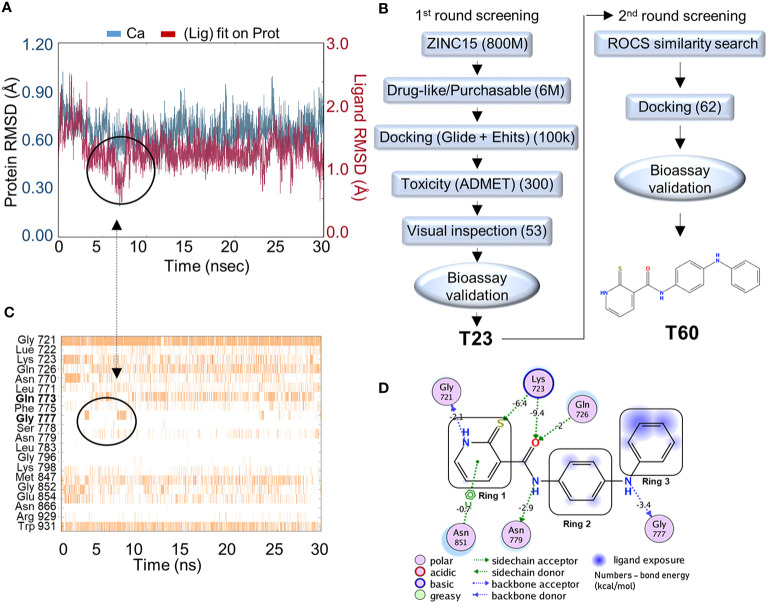

In silico screening for TOP2 inhibitors. (A) Molecular dynamics simulation of the docking pocket (blue) and T60 inside the TOP2A docking pocket (red) in 30ns. (B) A computer-aided drug design (CADD)_pipeline was applied to screen for TOP2 binders. Two rounds of virtual screening protocol combined with K-DNA decatenation and relaxation bioassays led to the discovery of the lead compound, T60. (C) A bar chart of protein–ligand contacts during the 30 ns simulation period. The interchanging bond formation (circled) between Gln773 and Gly777 is corresponding to T60 RMSD (circled) from (A) in the first 8 ns. (D) A schematic diagram shows T60 atoms interacting with surrounding protein residues of TOP2A. Bond energies were shown in kcal/mol.